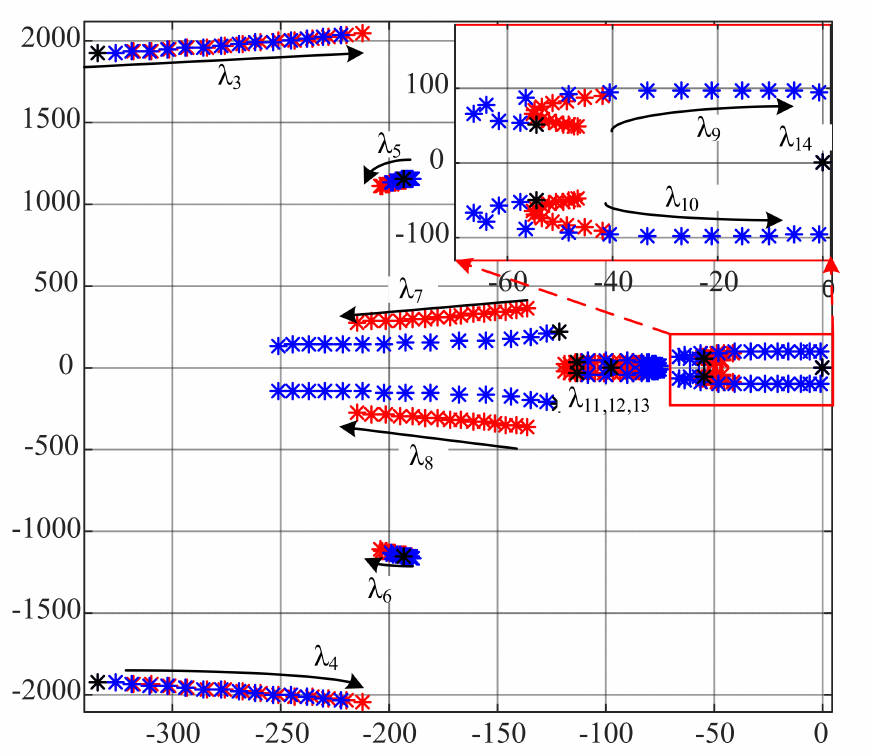
Figure 12. Eigenvalues of the system when solar insolation values